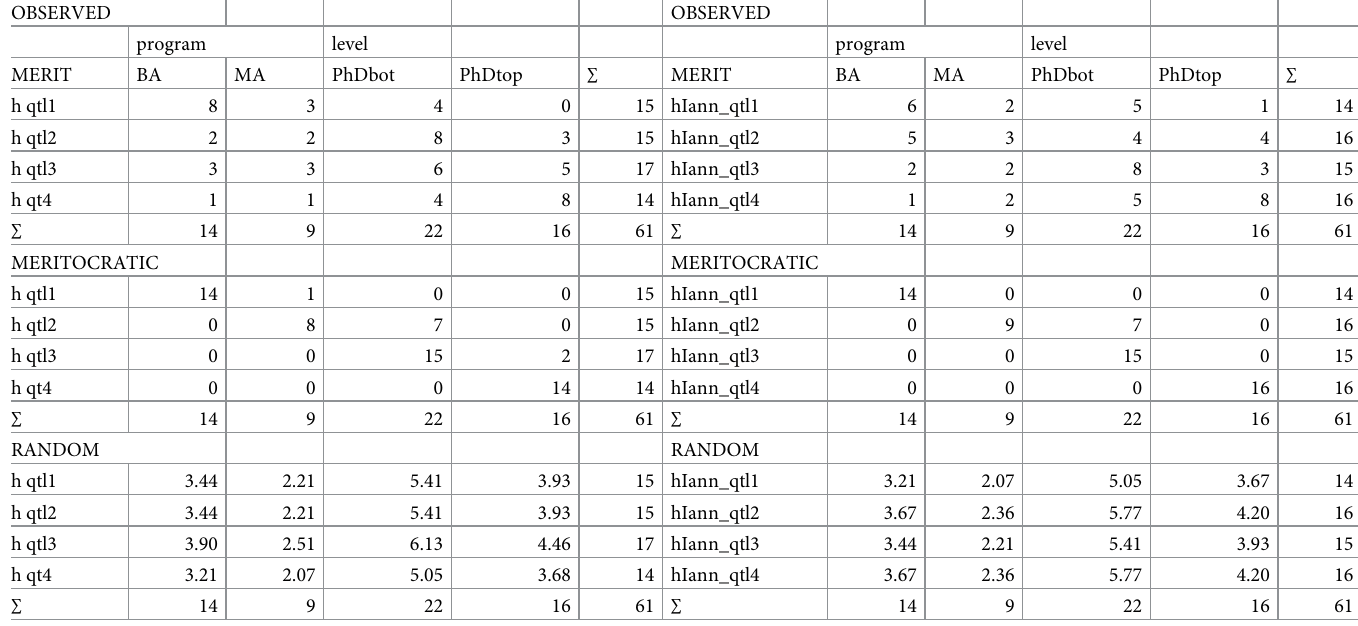
Table 6. Observed, meritocratic, and random allocation to program level (BA, MA, NRC-bottom-half PhD, NRC-top-half PhD) by quartiles (“qtl”) of h and hIann . 1 .